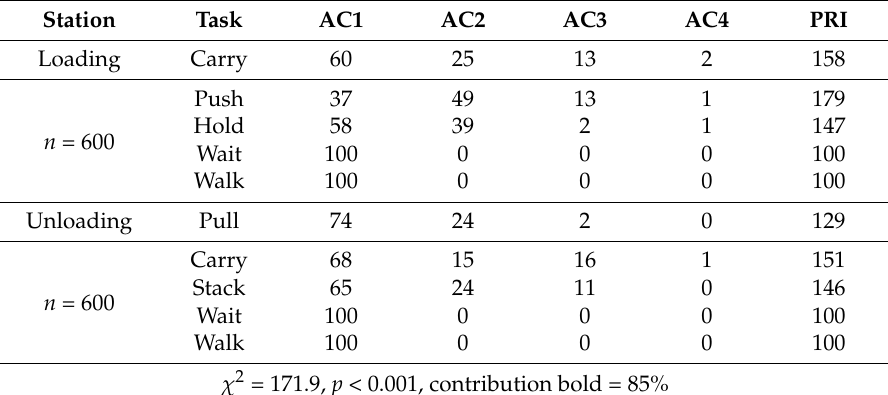
Table 4. Percent distribution of observed frames among postural risk classes, by task type.